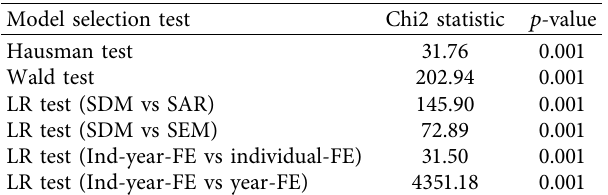
Table 4: Model selection tests for the spatial econometric